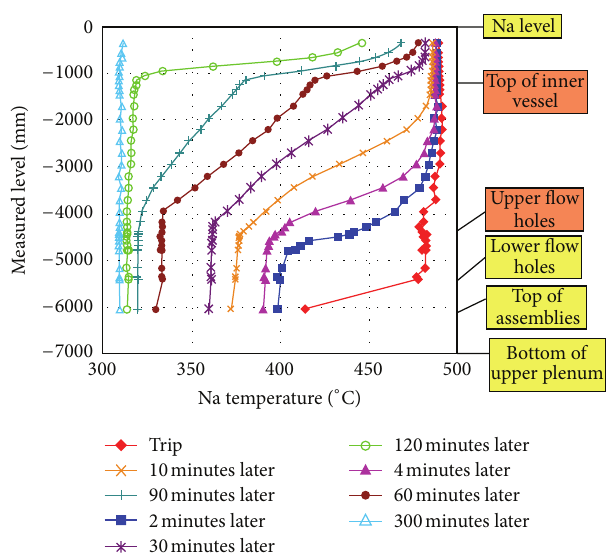
Figure 3: Measured temperature distribution on